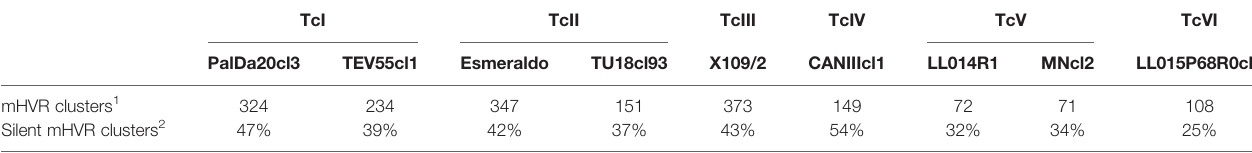
TABLE 2 | Relationship between mHVR clusters and gRNA